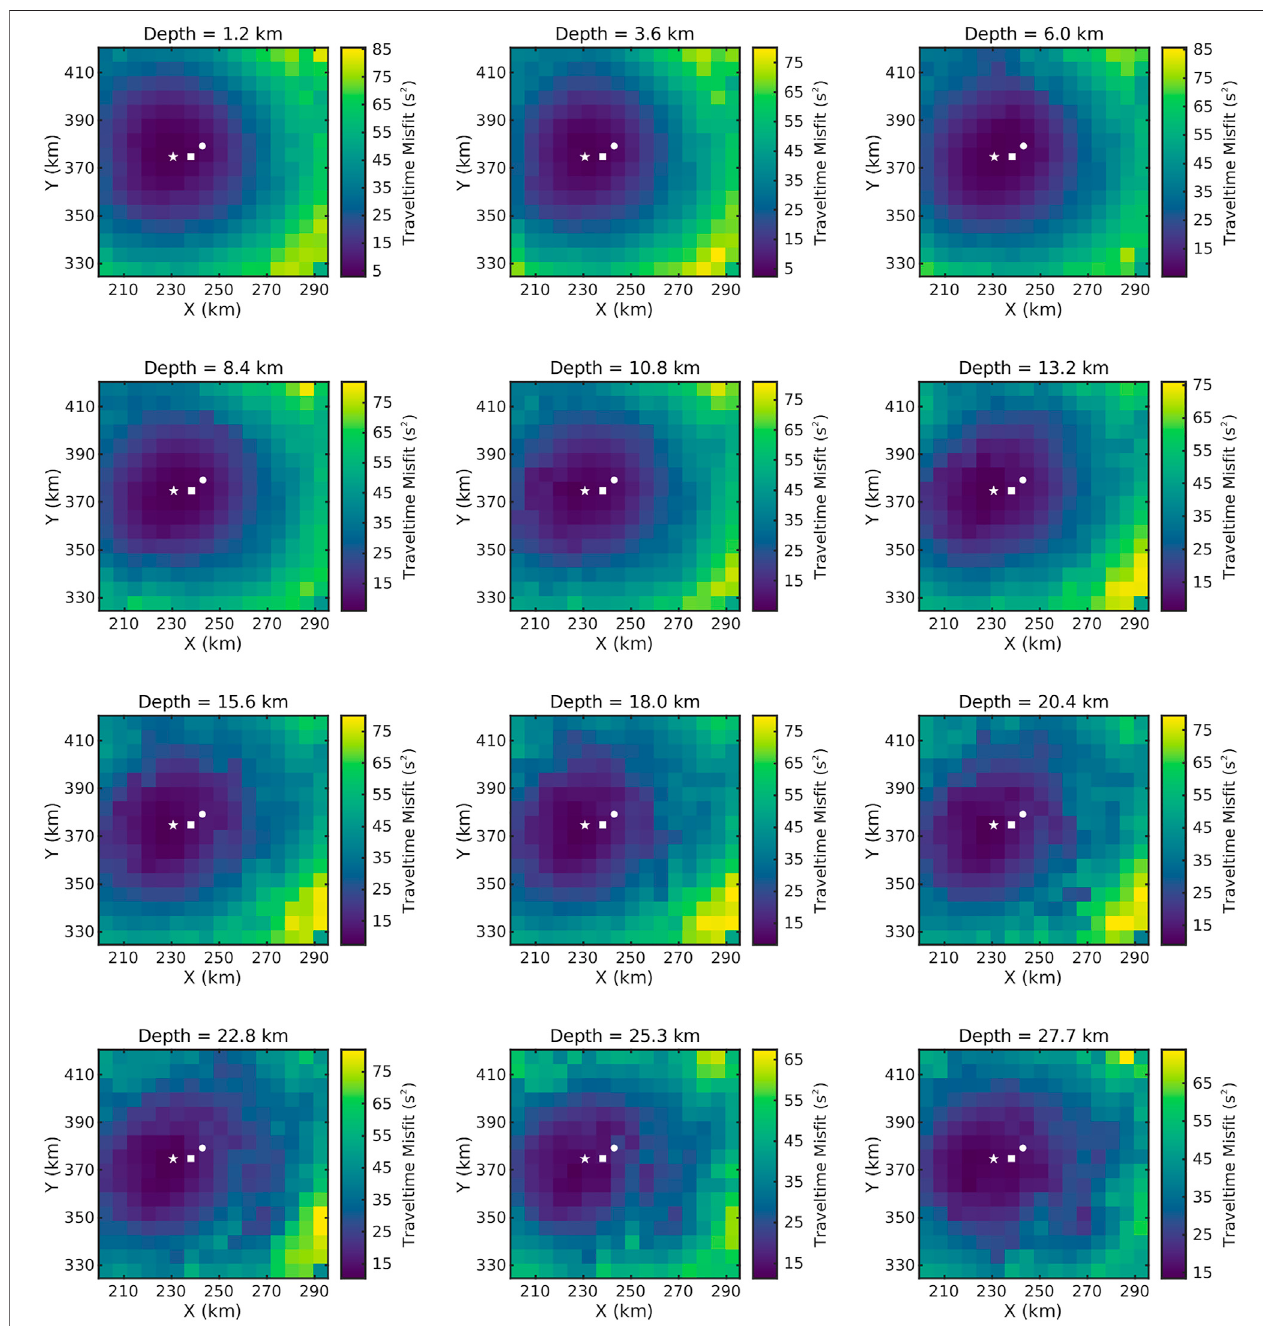
FIGURE 7 | Traveltime mis fi t maps along with the centroid location in this study (white star), epicenter location by CENC (white square) and centroid location by Global CMT (white dot) at various depth from 1.2 km to 27.7 km.